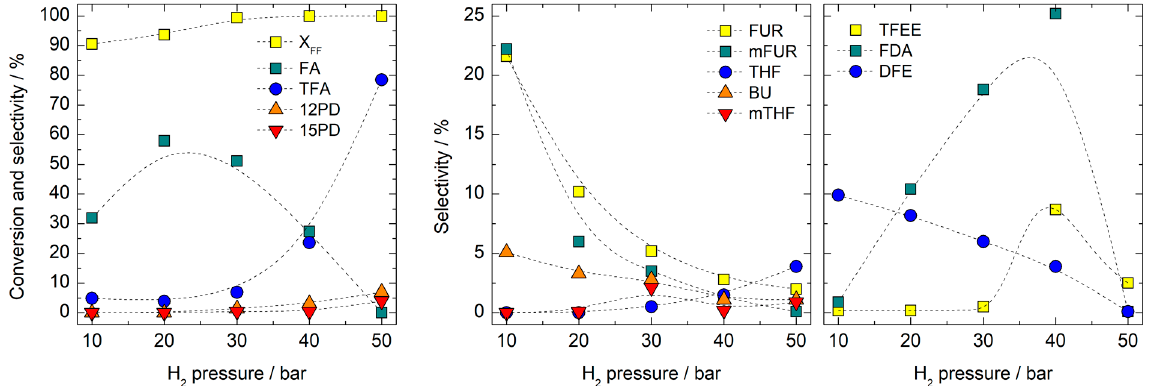
Figure 8. Furfural conversion and product selectivity over Ni 2 Mg 1 Al-R: effect of hydrogen pressure at 4 h and 190 °C using 5 wt.% FF in ethanol (the dashed lines only indicate